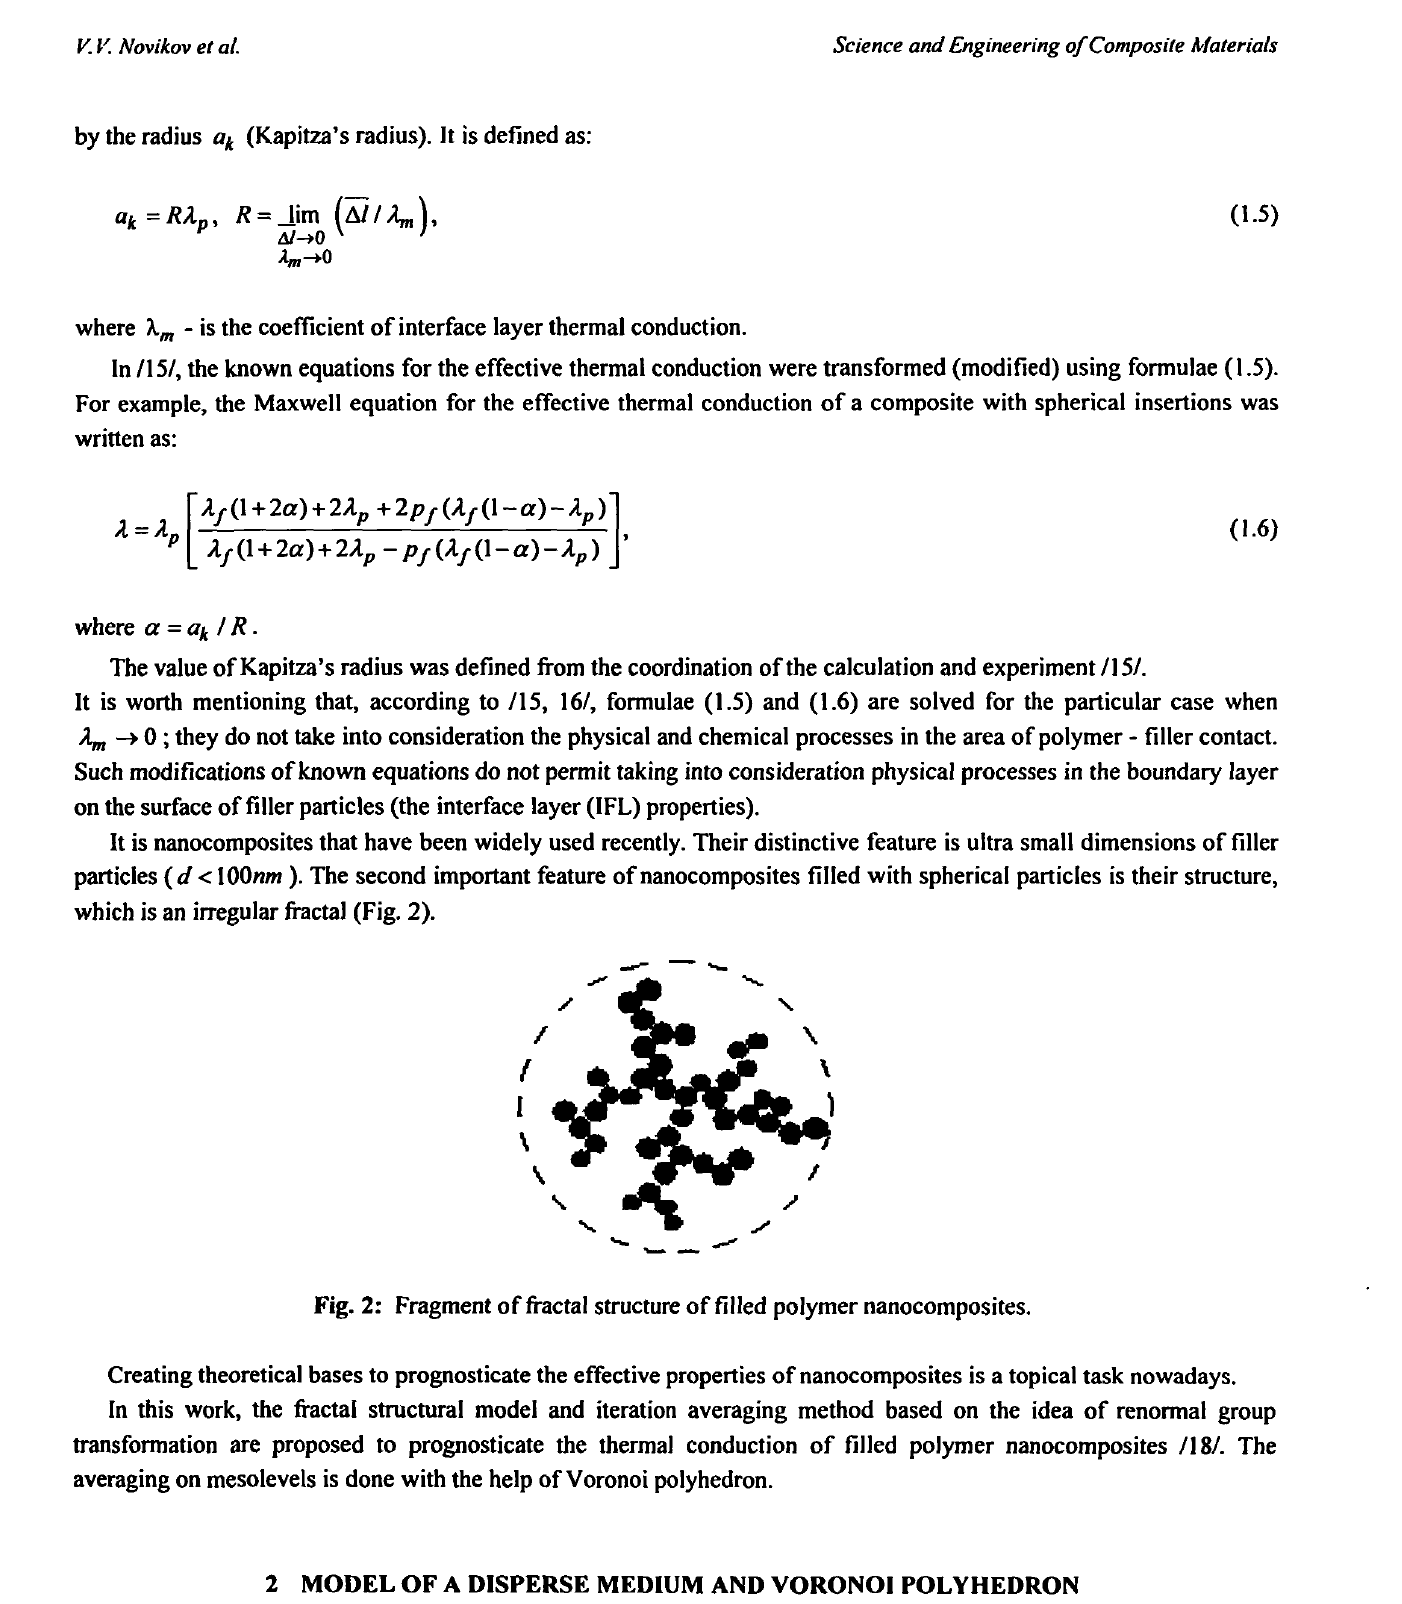
Fig. 2: Fragment of fractal structure of filled polymer